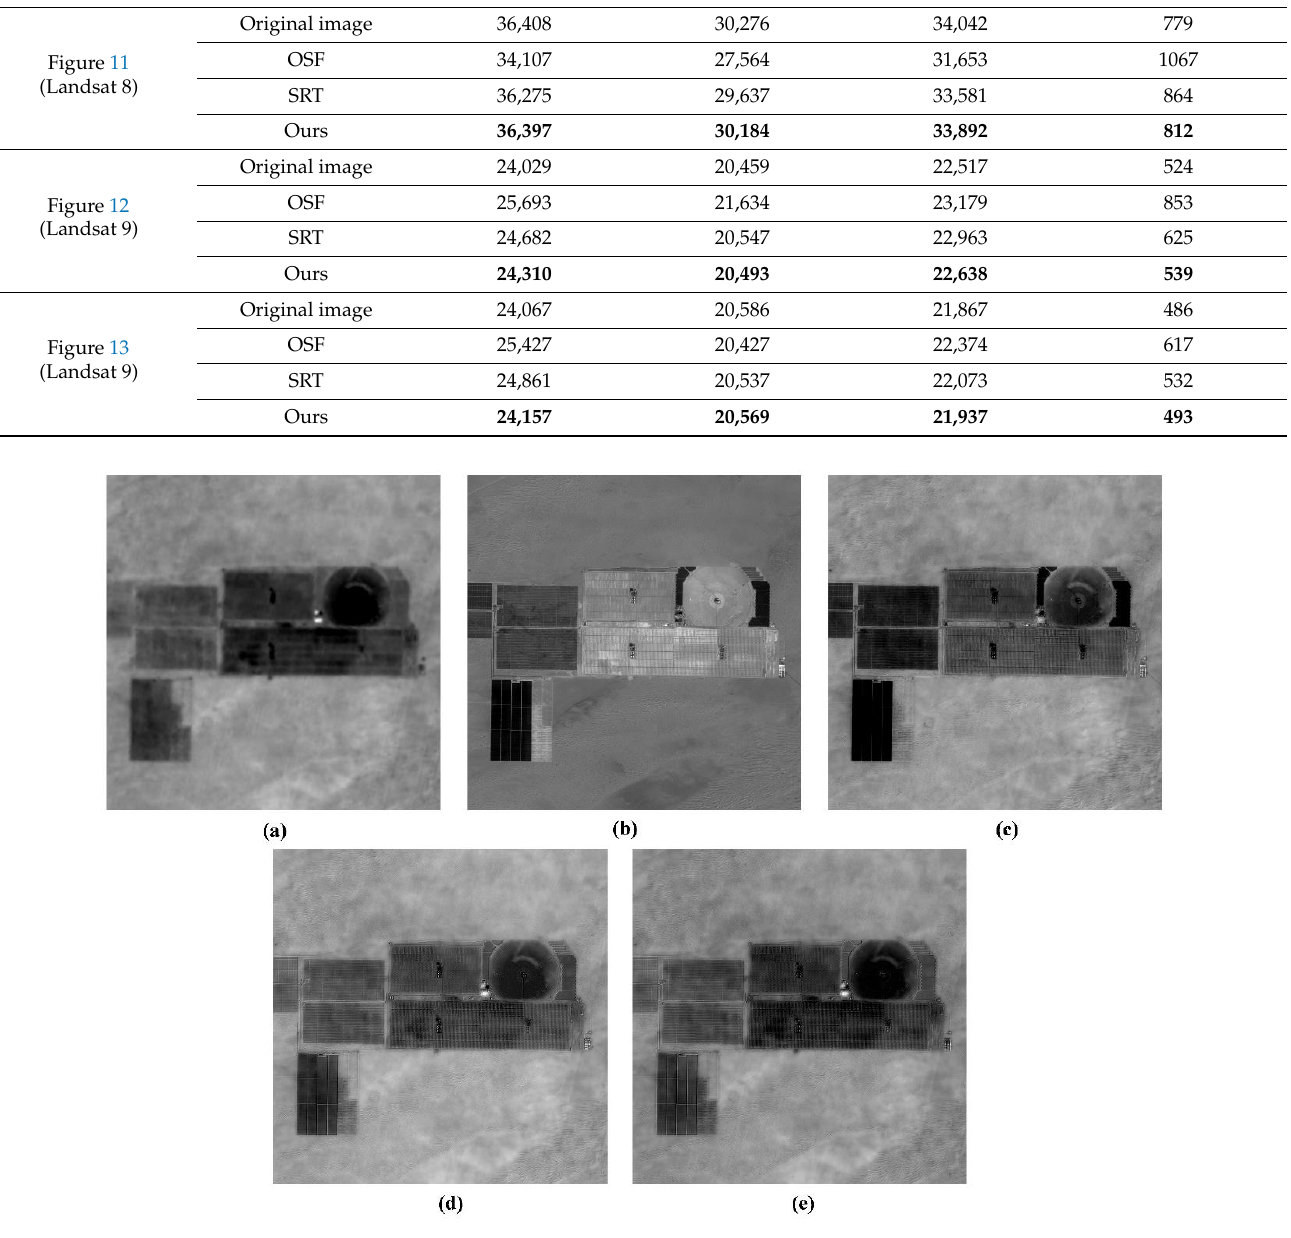
Figure 11. Experimental results of different fusion algorithms on Landsat8 data: ( a ) Landsat8 thermal infrared band image resolution of 100 m; ( b ) Landsat8 panchromatic band image resolution of 15 m; ( c ) fusion results of OSF algorithm; ( d ) fusion results of SRT algorithm; ( e ) experimental results of our proposed algorithm . Table 3. Summary of some statistics of thermal infrared images before and after fusion.